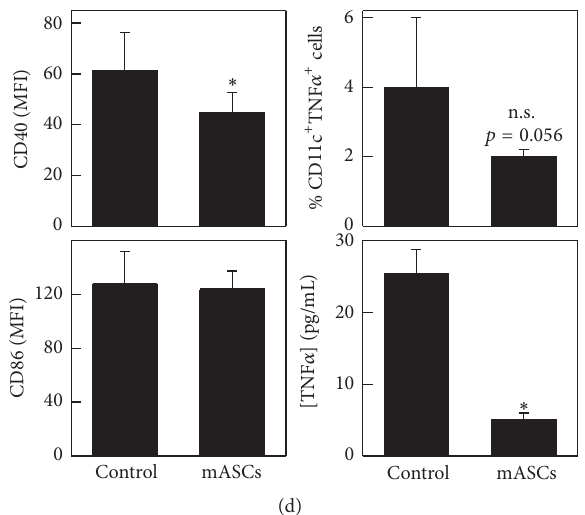
Figure 5: mASCs inhibit the maturation/activation of dendritic cells in vitro and in vivo. (a) mASCs inhibit the maturation of DCs in vitro. Bone marrow-derived DCs from C57BL/6 mice (4 × 10 5 cells/well) were matured/activated with LPS (1 𝜇 g/mL) in the absence or presence of different numbers of mASCs. After 48 hours, nonadherent or loosely adherent cells were harvested ( > 95% CD11c + DCs) and analyzed for surface expression of CD40, CD80, and CD86, and the culture supernatants were analyzed for TNF- 𝛼 , IL-10, and IL-12 content by ELISA. Data for nonstimulated immature DCs are shown as black bars. Results are shown as mean (SEM) of 3 (CD40, CD80, and CD86 FACS and IL-12 ELISA) or 4 (IL-10 and TNF- 𝛼 ELISA) independent experiments. ∗ 𝑝 < 0.05 versus control (no mASCs). (b) mASC-treated DCs show impaired costimulatory activity on T cells. C57Bl/6 DCs (4 × 10 5 cells) were LPS-matured in the absence (control) or presence of mASCs (2 ×